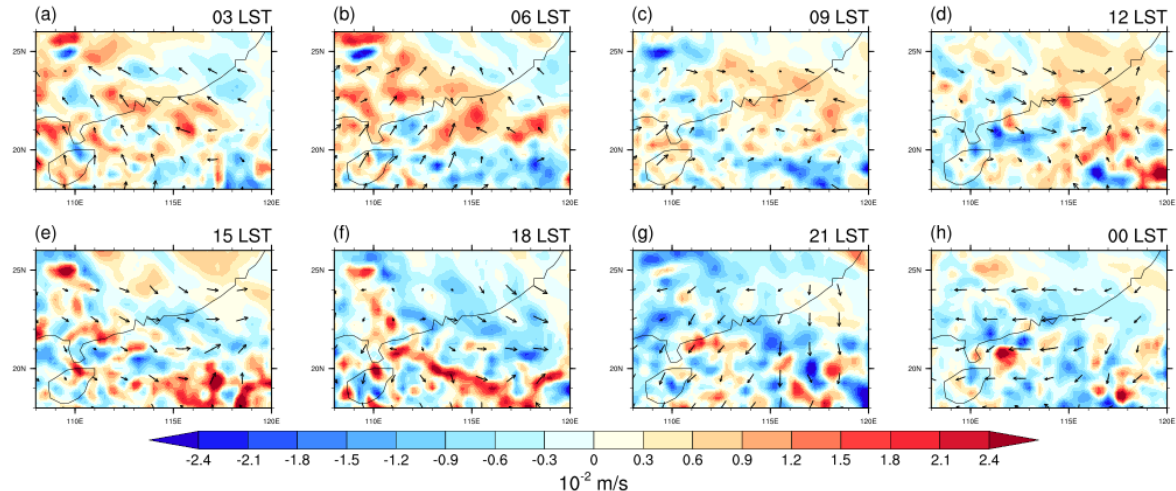
Figure 12. Composited anomalies of vertical velocity (shaded) and horizontal wind arrows (m/s) at 850 hPa over the SCCA area. Hourly data are obtained from June 2017 and shown in the panels based on 3 h intervals. SCCA is not marked up in this figure, and the shown map scale is the same as before.